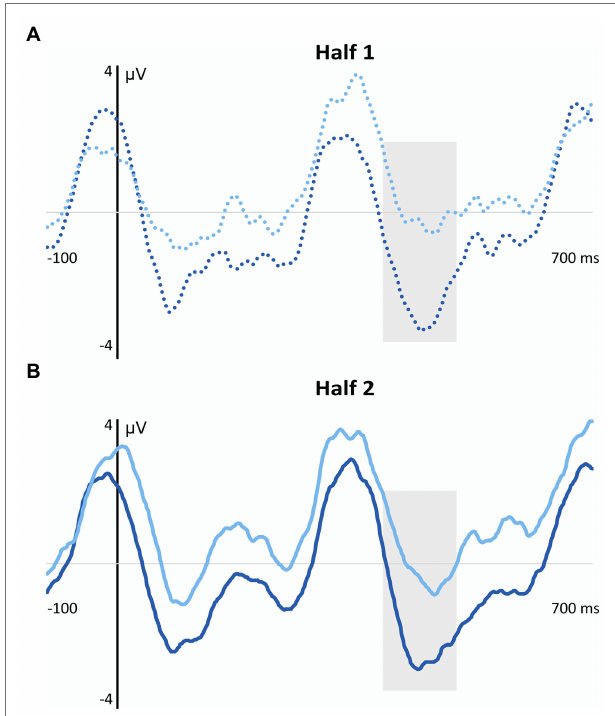
FIGURE 6 | Graphical representation of the aSL Task Effect observed in the N400 Component in the TLD Group as a Function of Type of “Word” and Length of Exposure. Gray shadowed rectangles indicate the N400 time window. (A) Task effect in the first half of the explicit aSL task in the TLD group for the low-TP condition. Light blue dotted line = implicit aSL task; Dark blue dotted line = explicit aSL task. (B) Task effect in the second half of the explicit aSL in the TLD group for the high-TP condition. Light blue solid line = implicit aSL task; Dark blue solid line = explicit aSL